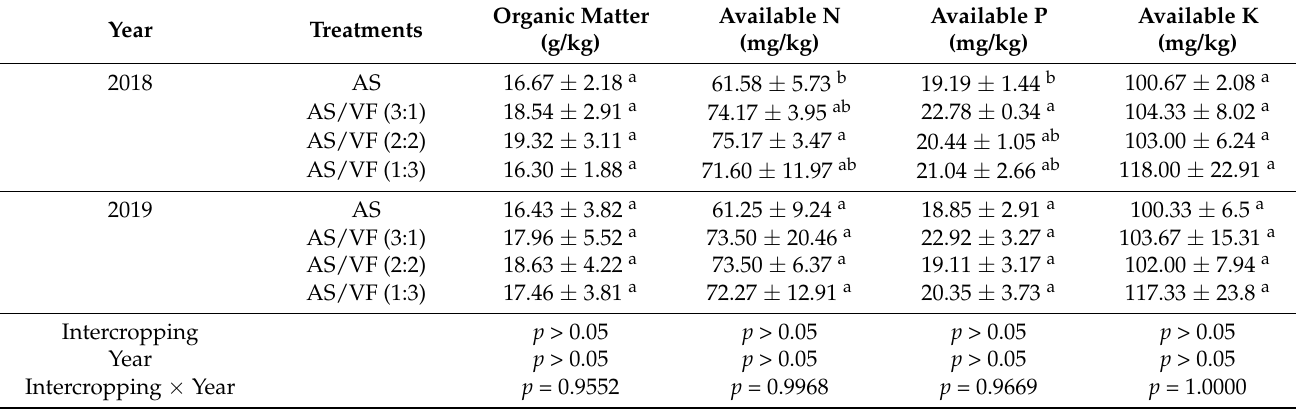
Table 1. Effects of cropping systems on soil